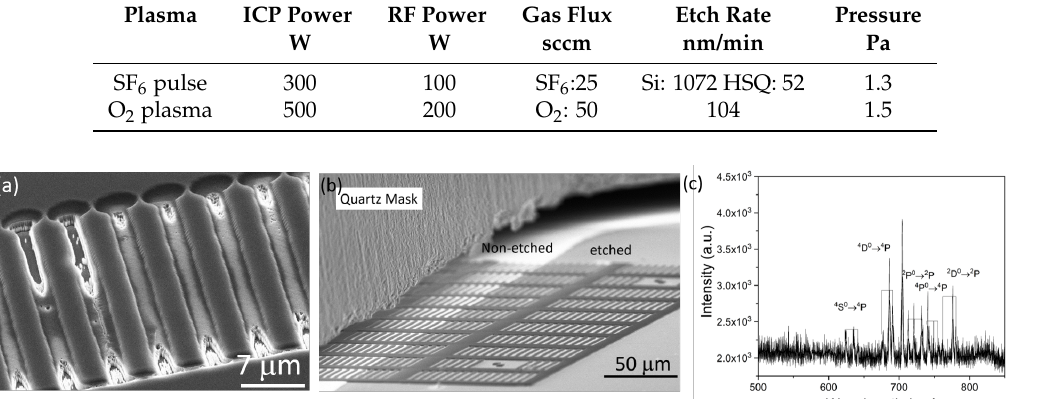
Figure 2. ( a ) Pattern of holding platforms etched with O 2 plasma without applying the SF 6 pulse plasma to remove the silicon layer, the SEM image shows the bare SCD structures. Strong micro-masking and corresponding roughening as well as a partial etch stop are visible ( b ) Scanning electron microscope (SEM) image of SCD surface with HSQ structures, here platforms, after SF 6 pulse. A part of the platforms is covered with a quartz plate (marked in the image) during the SF 6 pulse. The strongly reduced brightness of the etched surface in contrast to non-etched surface indicates the complete removal of the silicon adhesion layer. We furthermore observe no or minor etching of SCD during the SF 6 pulse and no roughening of the exposed SCD surface. ( c ) Optical emission spectrum of the SF 6 pulse plasma step indicating presence of fluoride (F − ) species responsible for selective removal of silicon from the SCD surface.